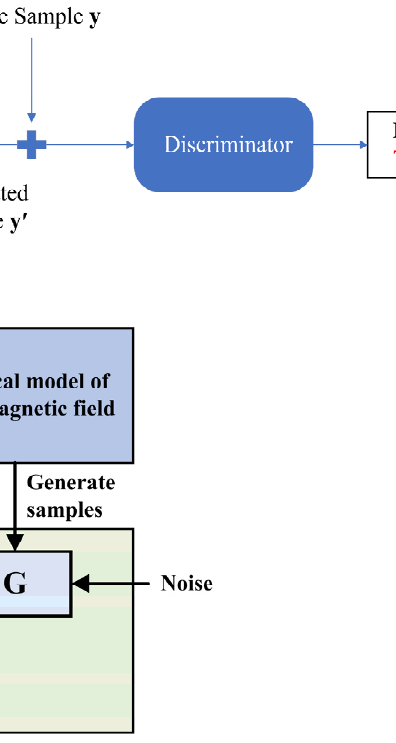
Figure 7. Basic structure of GAN in electromagnetic field.